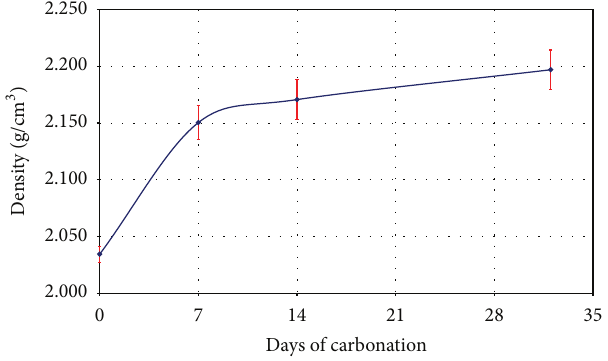
Figure 5: Evolution of the density of cement mortar during